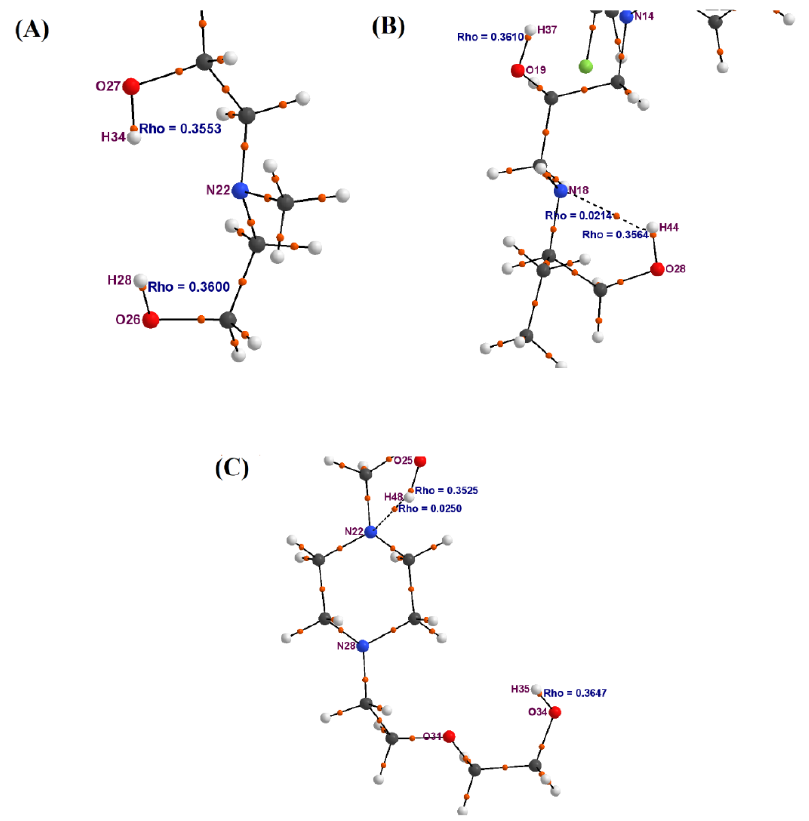
Figure 4. The molecular graphs of the side chain for MAE-TPR ( A ), Abu-TPR ( B ), and HEE-FLU ( C ) in aqueous medium. The electron density (Rho) values of the BCPs were calculated on the basis of the wave function, using AIMAll software.